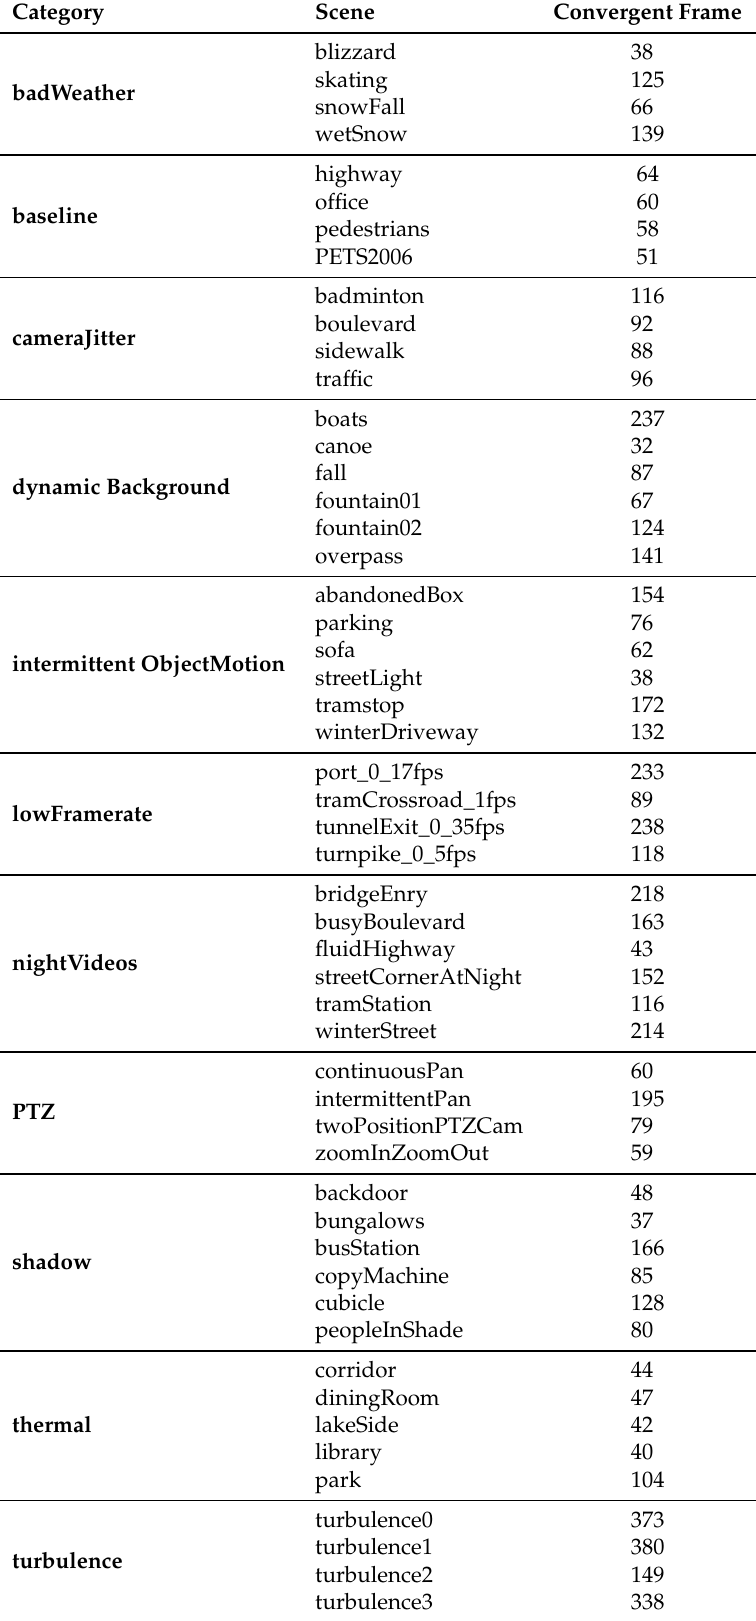
Table 5. Convergent frames of all scenes in each category in CDnet